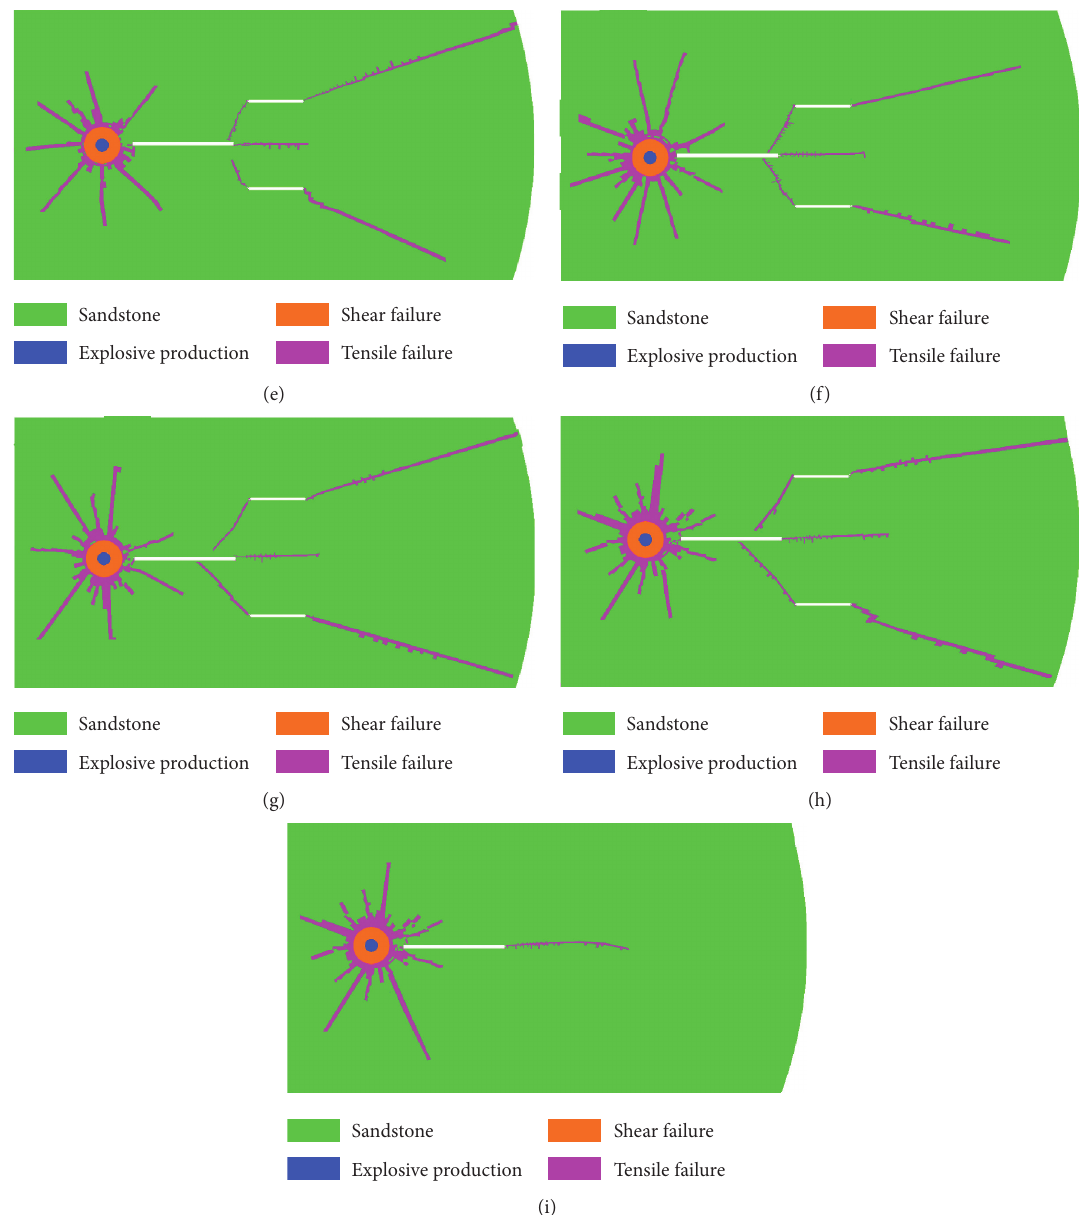
Figure 13: Simulation results for the specimens with different distances between parallel cracks. (a) S � 20mm and propagation length: 20.41 mm. (b) S � 30mm and propagation length: 32.01mm. (c) S � 40mm and propagation length: 36.13mm. (d) S � 50 mm and propagation length: 37.26mm. (e) S � 60 mm and propagation length: 49.86mm. (f) S � 70mm and propagation length: 54.06mm. (g) S � 80mm and propagation length: 53.01mm. (h) S � 90mm and propagation length: 72.04mm. (i) No existing parallel cracks